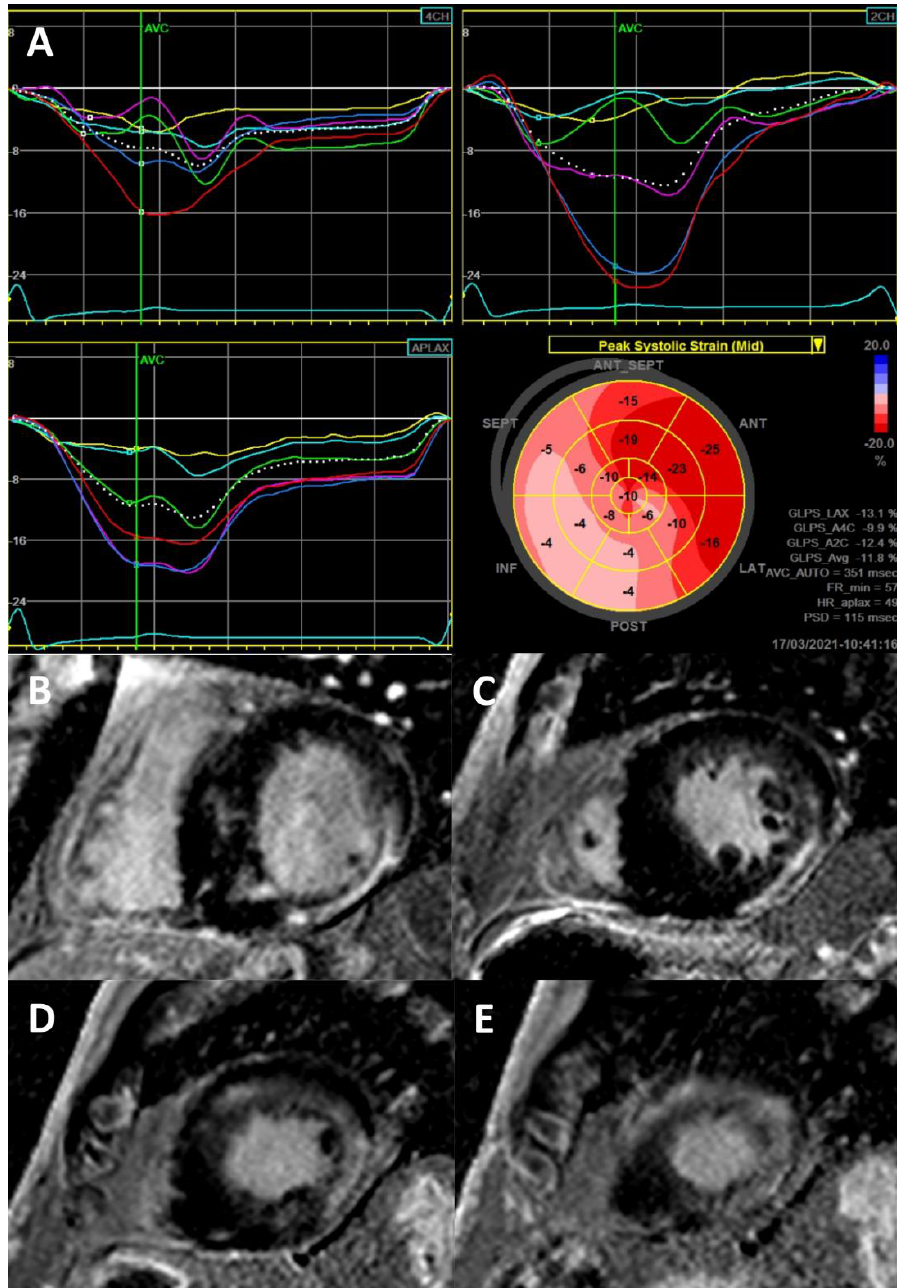
Figure 3. Strain echocardiography for the detection of LGE. ( A ) Transthoracic echocardiogram with 2D-strain analysis by speckle tracking showing reduction of longitudinal strain, particularly in the inferolateral, inferior and inferoseptal walls and apex, in a 73-year-old male Fabry patient; ( B – E ) Cardiac MRI (3.0 Tesla) with LGE in short-axis slices, from the LV base to the apex, showing fibrosis in the same regions where the reduction in longitudinal strain was more pronounced.